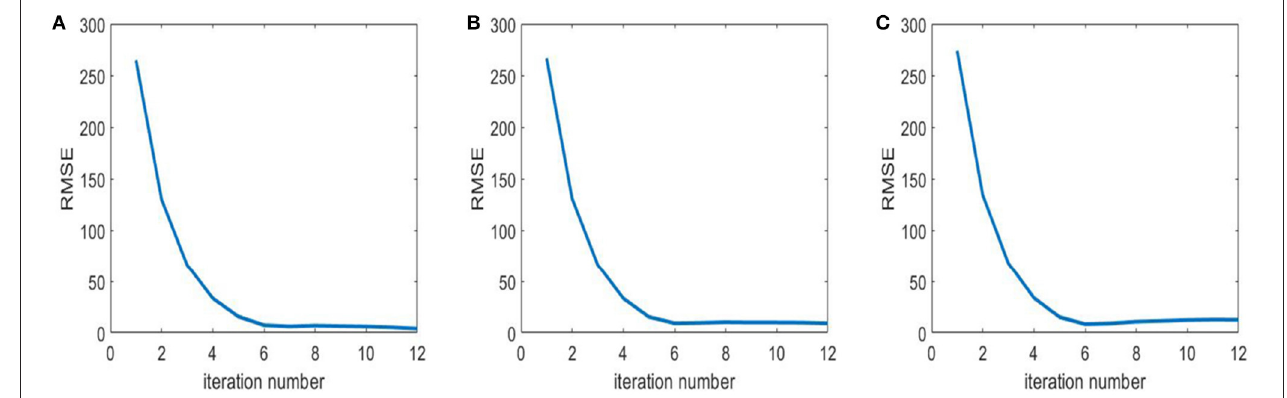
FIGURE 6 | Root Mean Square Error (RMSE) of Teflon in Figure 1 to reveal the convergence rate of the proposed algorithm. From left, (A) RMSE of Teflon under 40 kev; (B) RMSE of Teflon under 50 kev; (C) RMSE of Teflon under 100kev.